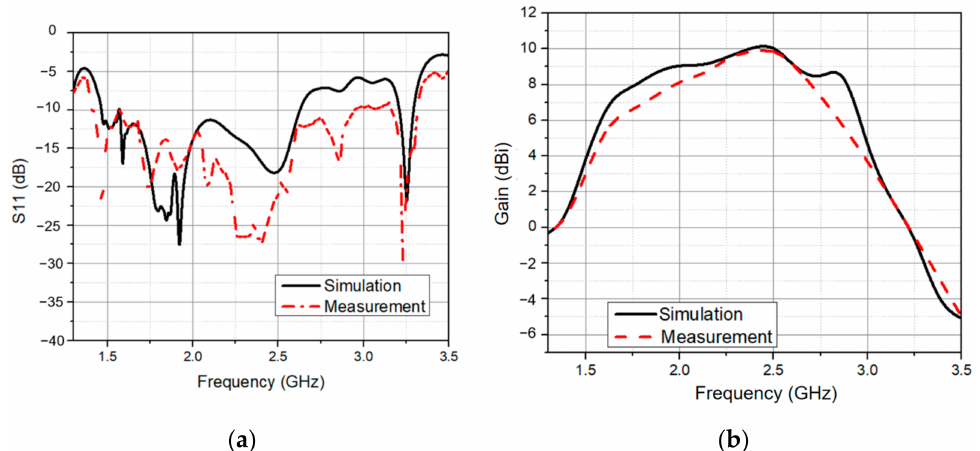
Figure 7. ( a ) Simulated and measured reflection coefficient of the wideband and CP antenna; ( b ) simulated and measured gain of the wideband and CP antenna.